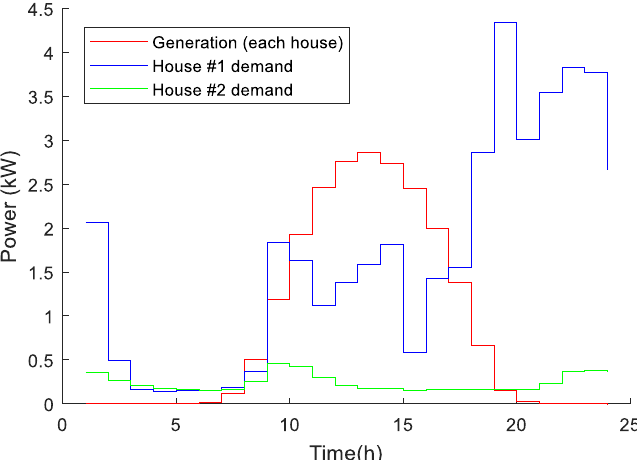
Figure 2. Generated and demanded average hourly power in both households.